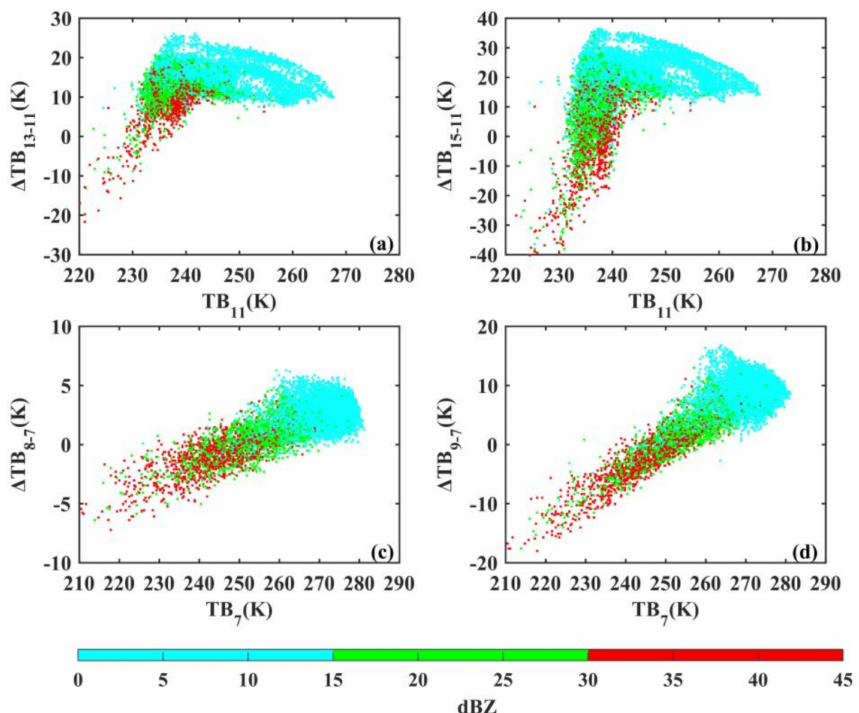
Figure6. Scatterplotsofobservedbrightnesstemperaturedi ff erenceasafunctionofobservedbrightness temperature for channel 11 ( a , b ) and channel 7 ( c , d ); the color of plots represents ground-based radar